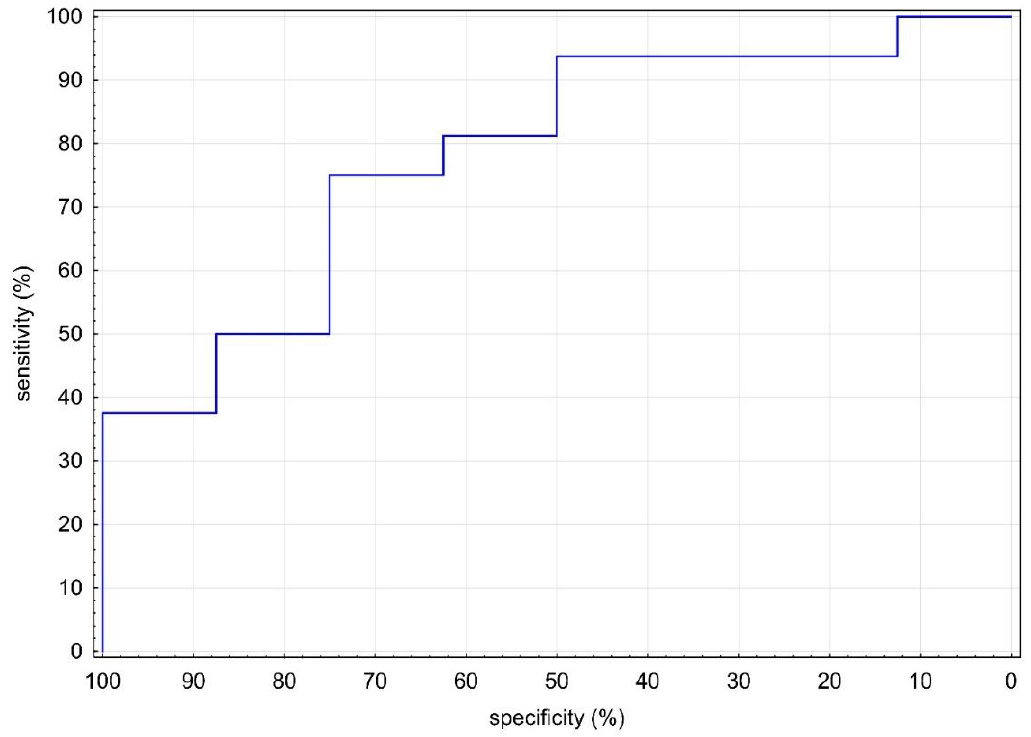
Figure 5. ROC curve of S-cystatin C levels in MIS-C group between RHI ≤ 1.4 and RHI > 1.4. MIS-C: multisystem inflammatory syndrome in children; RHI: reactive hyperemic index.